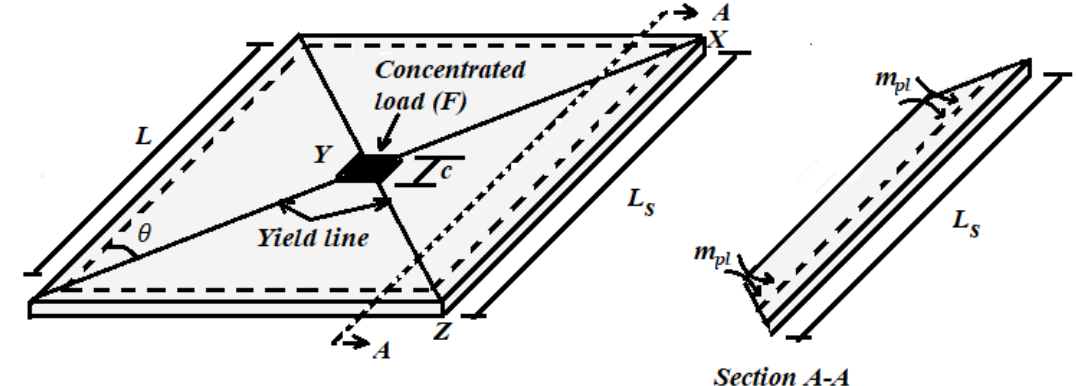
Figure 21. Formation of the yield-line mechanism of SCS slab under concentrated patch load.